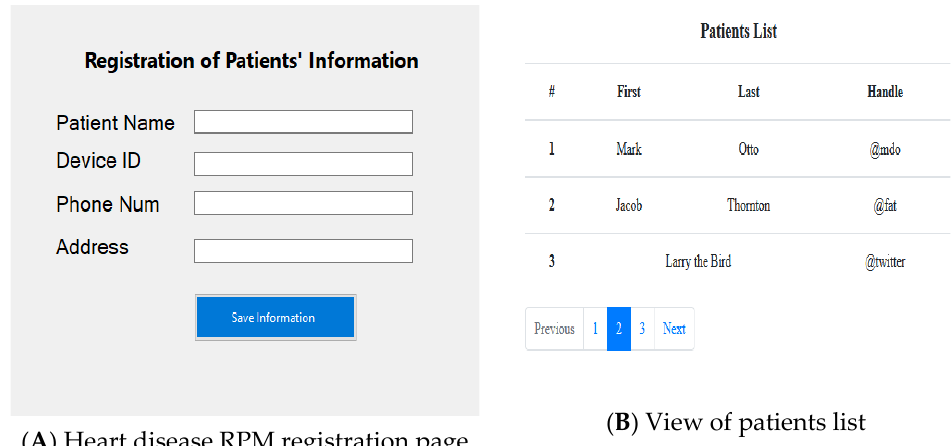
Figure 6. ( A , B ) shows the Heart disease RPM registration page and View of patients list, respec- tively.